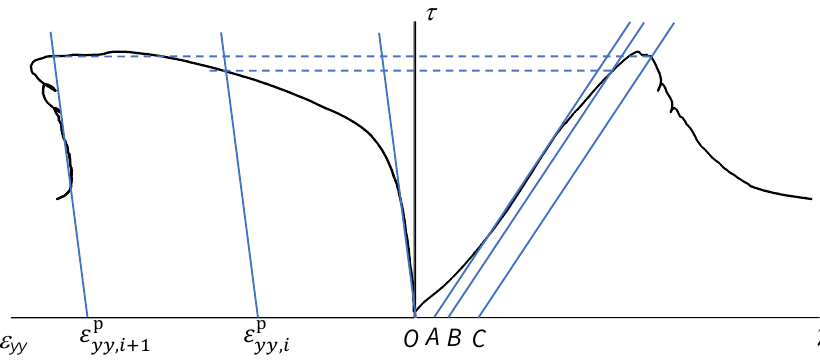
Figure 7. Sketch of the method for determining the plastic shear and normal strain values.